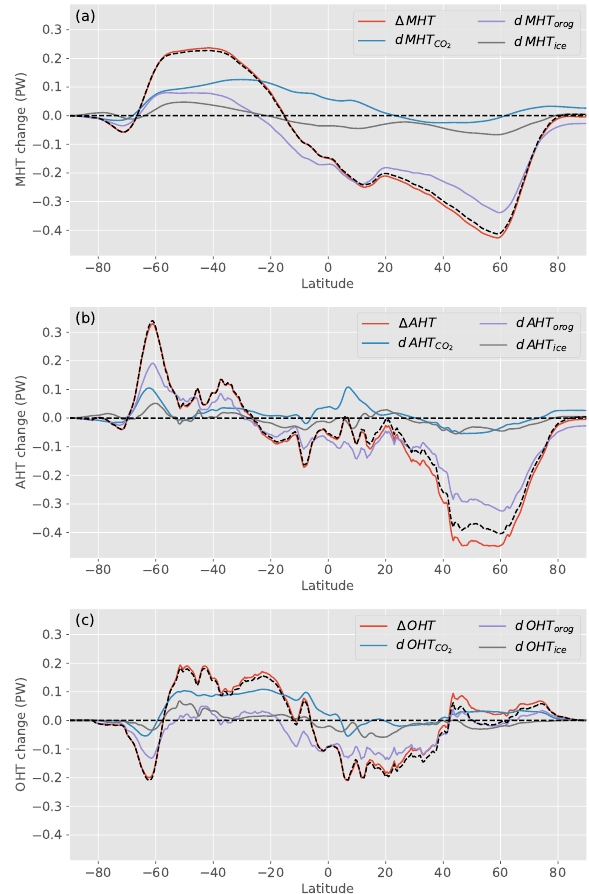
Figure 15. Meridional heat transport anomalies (mid-Pliocene mi- nus PI) and their factorization. (a) Total meridional heat transport, (b) atmospheric heat transport, and (c) oceanic heat transport. The dashed black curve in each figure is the sum of the factorized com-